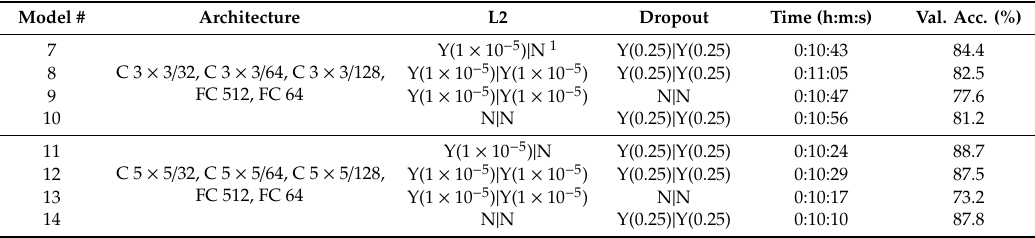
Table 5. Experimental results of different L2 regularization and dropout parameters. The convolutional layers’ parameters are denoted as “C kernel size/number of kernels”. The fully connected layers are denoted as “FC number of hidden units”. Epoch = 30 and learning rate = 1 × 10 − 4 . Model #